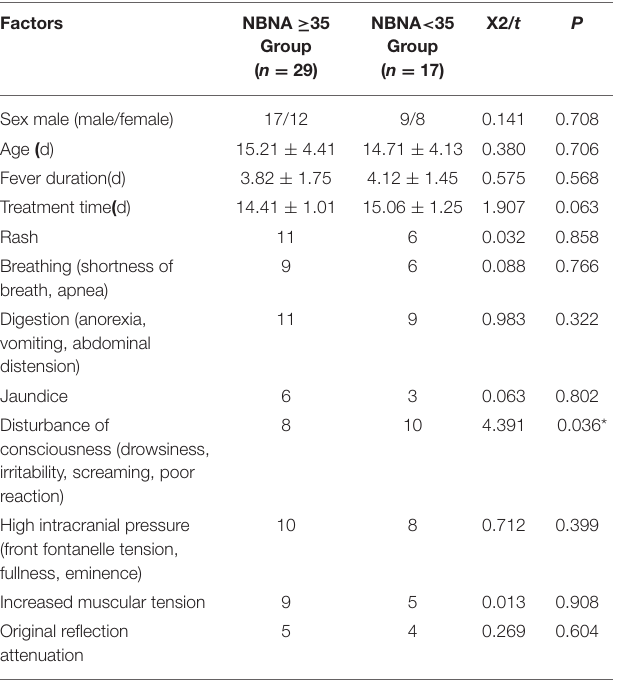
TABLE 1 | Comparison of clinical symptoms and signs of neonatal HFMD with encephalitis.